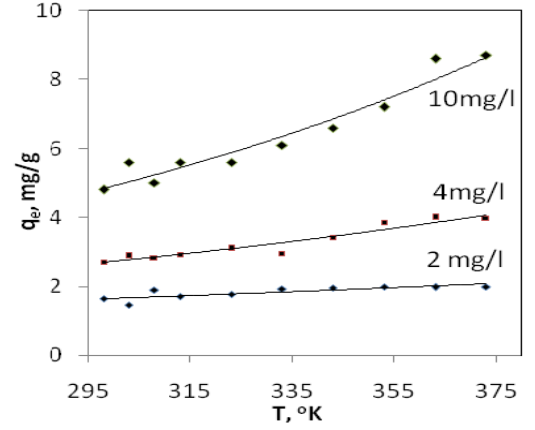
Fig.6. Effect of temperature for the different concentrations at pH = 5.0.